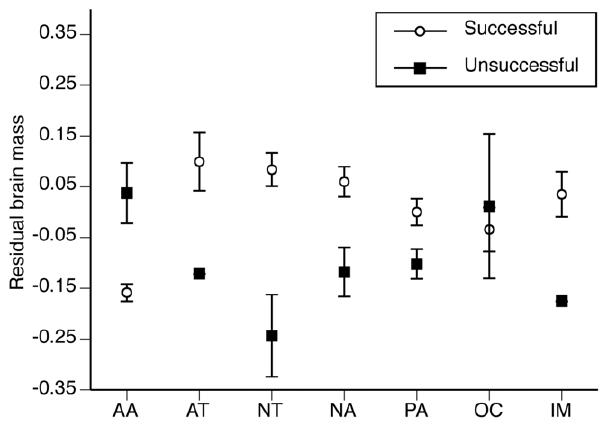
Figure 1. Mean ( ± SE) residual brain mass of amphibian and reptile species that were successful (open circles) and unsuc- cessful (dark squares) in establishing populations outside of their native geographic ranges in seven different biogeo- graphic realms. AA = Australasia, AT = Afrotropics, NT = Neotropics, NA = Nearctic, PA = Palearctic, OC = Oceania, and IM = Indomalaysia. Lack of standard errors in the AT and IM realms reflect low numbers of unsuccessful introductions.